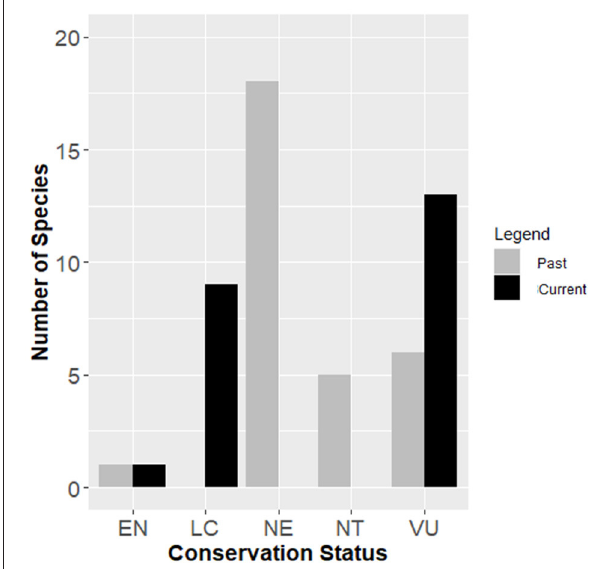
FIGURE 3 | Species geographical range (AOO, area of occupancy; EOO, extent of occurrence) for the 23 Aeonium species classified under IUCN categories (LC, Least Concern; VU, Vulnerable; EN, Endangered).